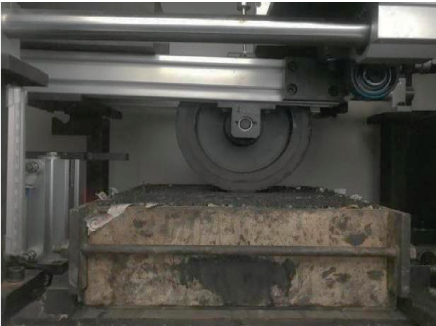
Figure 6: Asphalt mixture rutting